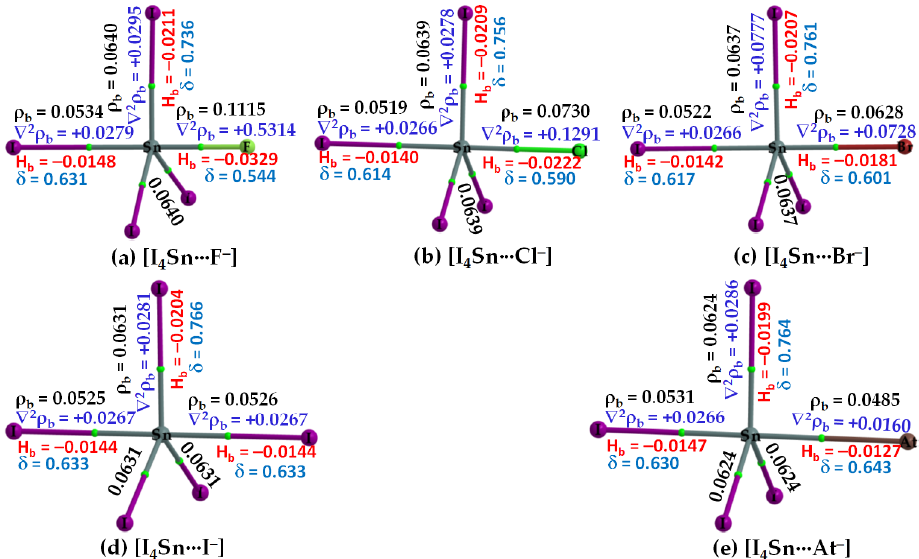
Figure 6. ( a – e ) [ ω B97X-D/def2-QZVPPD] level QTIM-based molecular graphs of [I 4 Ge ··· X − ] (X = F, Cl, Br, I, At), showing the bond paths (solid and dotted lines in atom color) and bond critical points (tiny spheres in green) between bonded atomic basins. Large spheres represent the atomic basins, with atoms labeled. The dotted black line in ( e ) is artificially drawn to represent the presence of tetrel bond between Ge and At. The charge density ( ρ b ), the Laplacian of the charge density ( ∇ 2 ρ b ), the total energy density (H b ), and the delocalization index ( δ ) values are shown in black, blue, red, and faint-blue fonts (in a.u.), respectively.